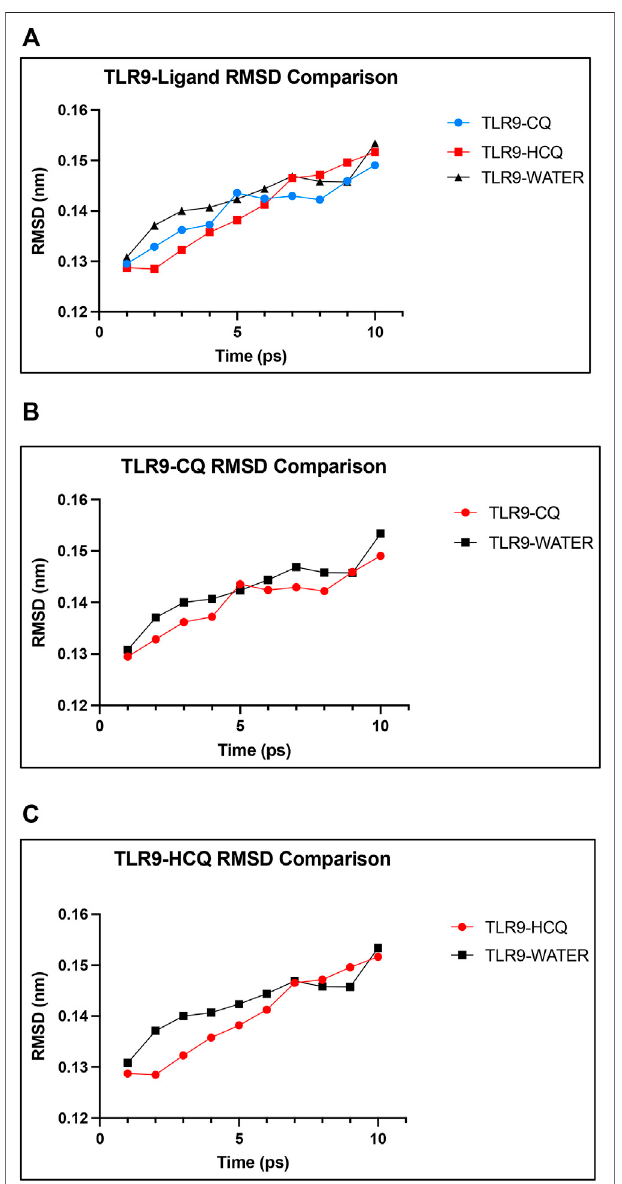
FIGURE 6 | The con fi rmation of the binding af fi nity of TLR9 to CQ and HCQ. (A) RMSD plot of the TLR9-CQ (shown in blue), TLR9-HCQ (shown in red), TLR9 solvated in water (shown in black) as a function of simulation time. (B) RMSD plot of TLR9-CQ and TLR9 solvated in water shows minimal difference between the curves. (C) RMSD plot of TLR9-HCQ and TLR9 solvated in water shows minimal difference between the curves. (D) A 10 ns time simulation quantifying RMSD of TLR9-CQ (shown in blue), TLR9-HCQ (showninred),TLR9solvatedinwater(showninblack). (E) A10 nssimulation quantifying RMSD of TLR9-CQ vs. TLR9 solvated in water shows minimal difference between the curves. (F) A 10 ns simulation quantifying RMSD plot of TLR9-HCQ and TLR9 solvated in water shows signi fi cant difference between the curves ( p <